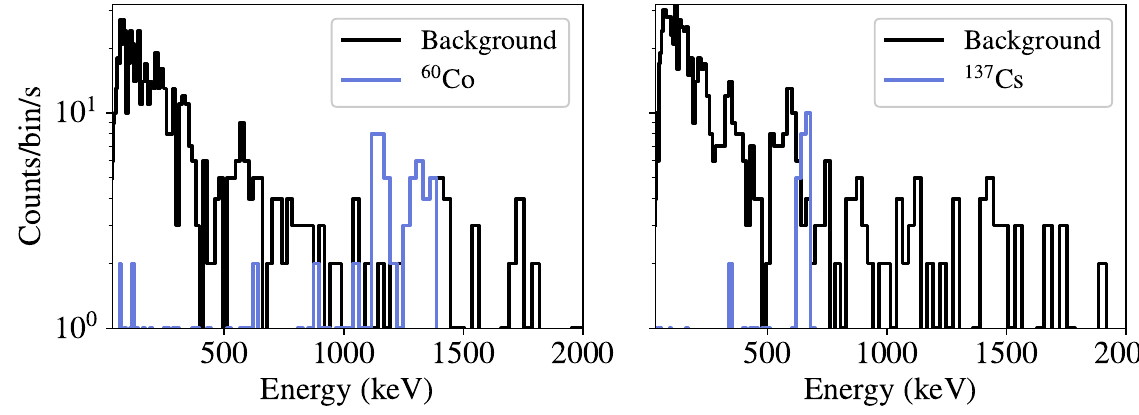
Figure 4. Comparison of two injection spectra. The left pane shows a random background spectrum and a random Poisson sample of a 50- µ Ci 60 Co source at a 5 m standoff, each having a 1-s integration time. The right pane shows a different random background spectrum and a Poisson sample of a 137 Cs source with the same parameters as the previous. The ratio of source-to-total counts is 0.11 for 60 Co and 0.04 for 137 Cs. Due to having few counts, these spectra do not contain the familiar peak behavior, and instead show small clusters of counts appearing at the characteristic energies of the sources (i.e., 1173 and 1332 kev for 60 Co and 662 keV for 137